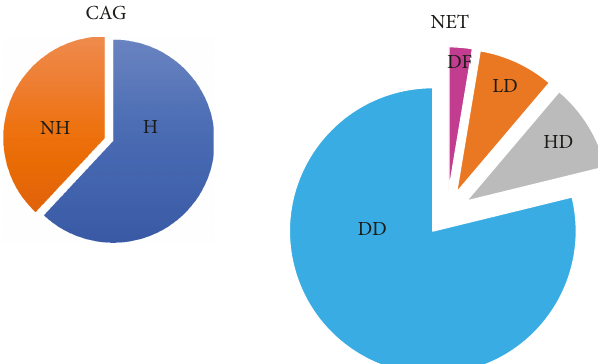
Figure 1: Distribution of Cg A in patients with NET and chronic atrophic gastritis (CAG). In the NET group, higher Cg A levels are observed in patients with di ff use disease (DD) compared with patients with local (LD) or hepatic (HD) disease. In the disease-free patients (DF), Cg A levels were the lowest of all. In the CAG group, higher Cg A levels are observed in patients with hyperplasia (H) of ECL cells, compared with patients without hyperplasia